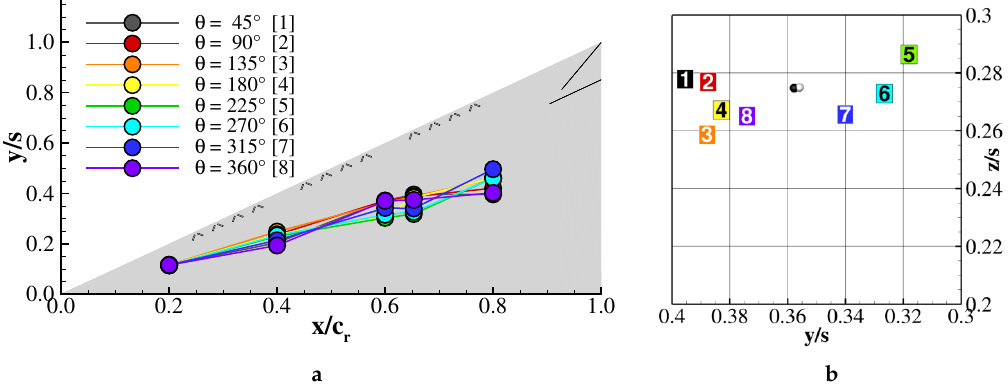
Figure 16. Phase averaged vortex axis location at α = 35 ◦ , F + = 2.6: ( a ) xy-plane and ( b ) x / c r = 0.65.